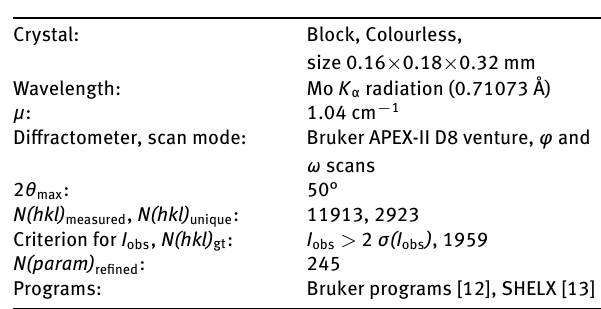
Table 1: Data collection and handling.